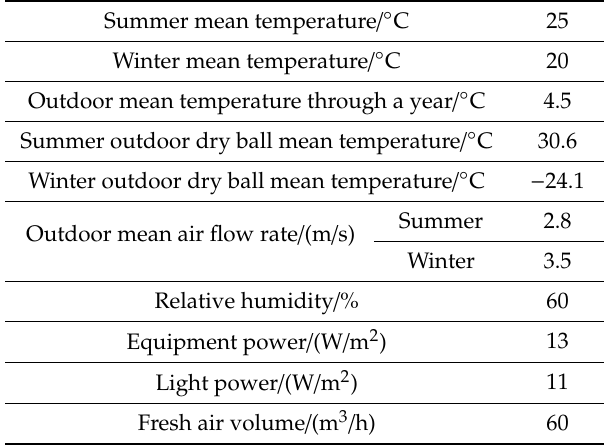
Table 2. Design parameters of heat transfer environment.